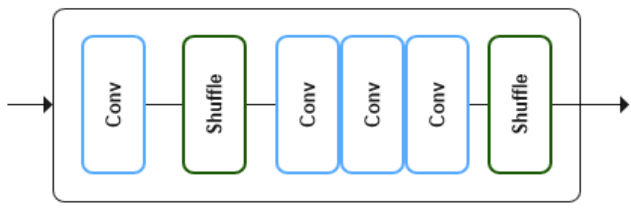
Figure 4. Progressive Upsampling Network Structure.